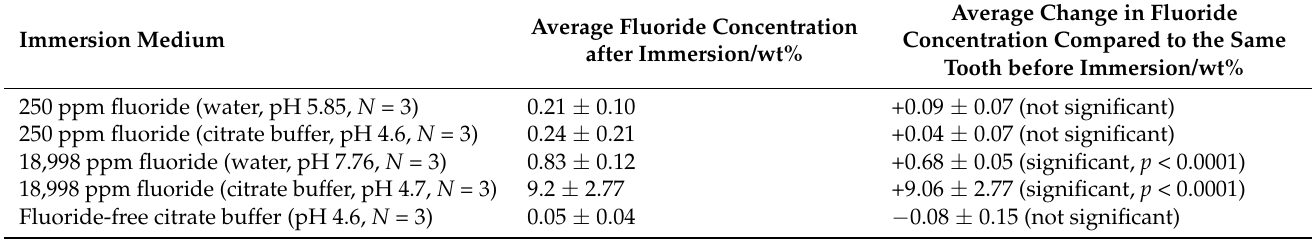
Table 1. Average fluoride concentration and average changes in the fluoride concentration after the immersion in fluoride solutions.